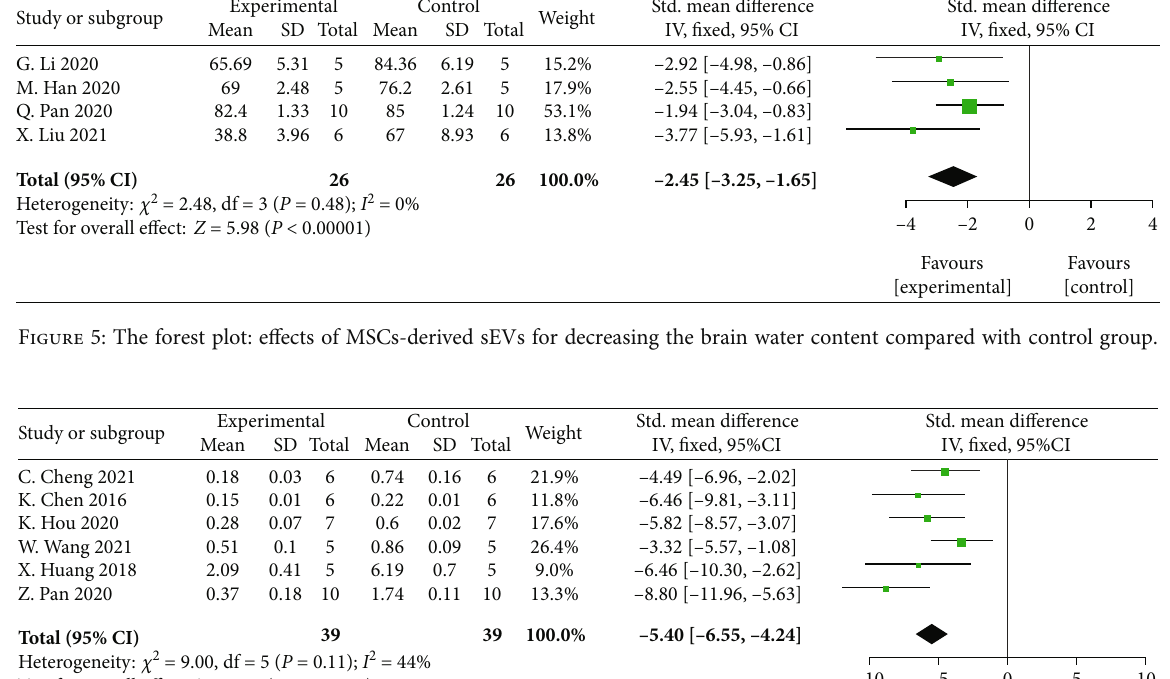
Total (95% CI) Heterogeneity: 𝜒 2 = 9.00, df = 5 ( P = 0.11); I 2 = 44% Test for overall effect: Z = 9.17 ( P < 0.00001)